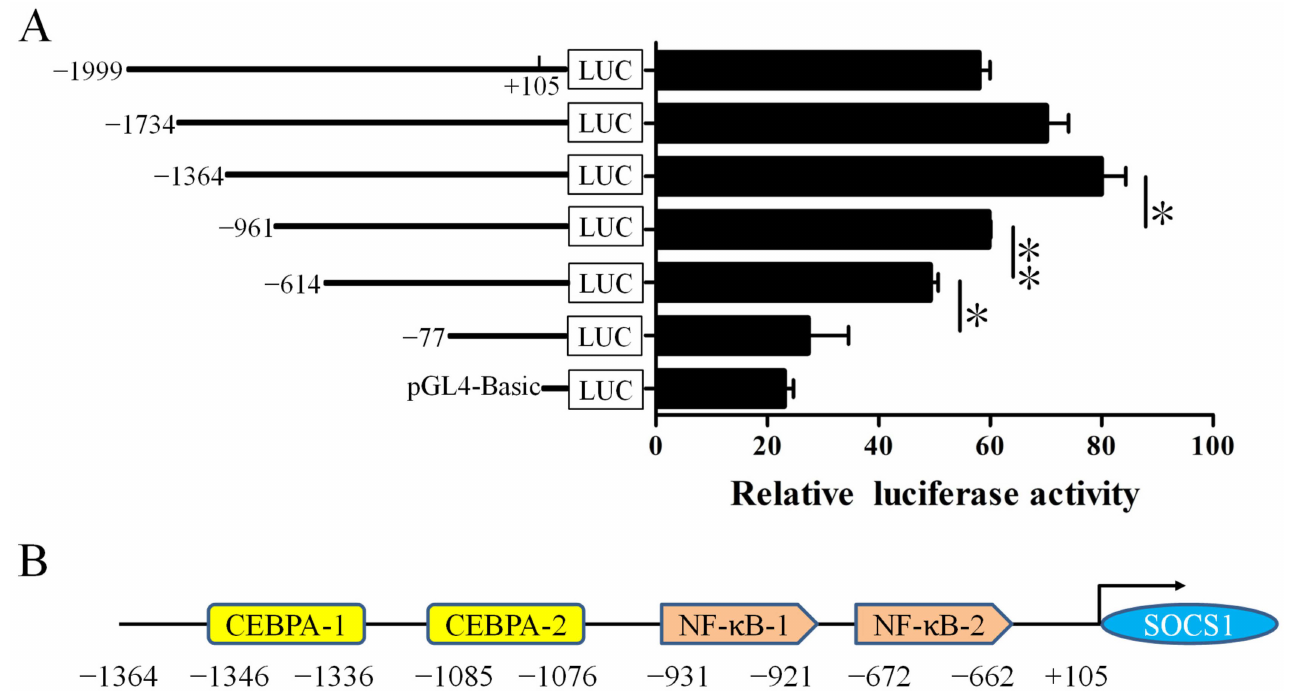
Figure 6. Identification of the core promoter region of SOCS1 and analysis of transcription factor binding sites. ( A ) Relative luciferase activity (Firefly: Renilla) after 48 h transfection with 5 (cid:48) progres- sive deletions of pGL- SOCS1 plasmids (pGL-( − 1999/+105), pGL-( − 1734/+105), pGL-( − 1364/+105), pGL-( − 961/+105), pGL-( − 614/+105) and pGL-( − 77/+105)). ( B ) Predicted transcription factor bind- ing sites in the core promoter region of buffalo SOCS1 . Data are presented as means ± SEM for three individual cultures; * p < 0.05, ** p <